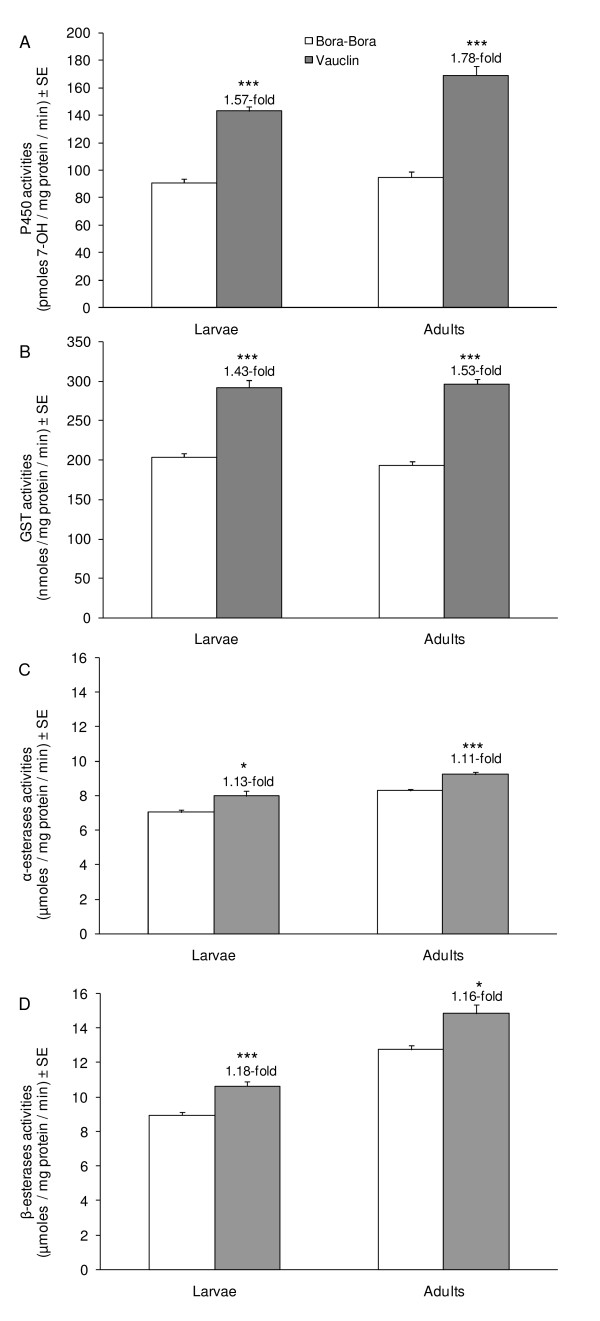
Comparison of detoxification enzymes activities between the insecticide-resistant strain Vauclin and the susceptible strain Bora-Bora. A) P450 activities were measured with the ECOD method [63] on 20 μg microsomal proteins after 15 min and expressed as pmol of 7-OH produced/mg microsomal protein/minute (± SE). B) GST activities were measured with the CDNB method [64] on 200 μg cytosolic proteins during 1 min and expressed as nmol of conjugated CDNB/μg protein/min (± SE). α-esterase (C) and β-esterase (D) activities were measured with the naphthyl acetate method [65] on 30 μg cytosolic proteins after 15 min and expressed as μmol α- or β-naphthol produced/mg protein/minute (± SE). For each strain and each life stage, 3 independent biological replicates were analyzed and measures were repeated 15, 15 and 30 times for P450, GST and esterase activities respectively. Statistical comparison of enzyme activities between the Vauclin and Bora-Bora strains were performed at each life stage separately with a Mann and Whitney's test (* p < 0.05, ** p < 0.01, *** p < 0.001).